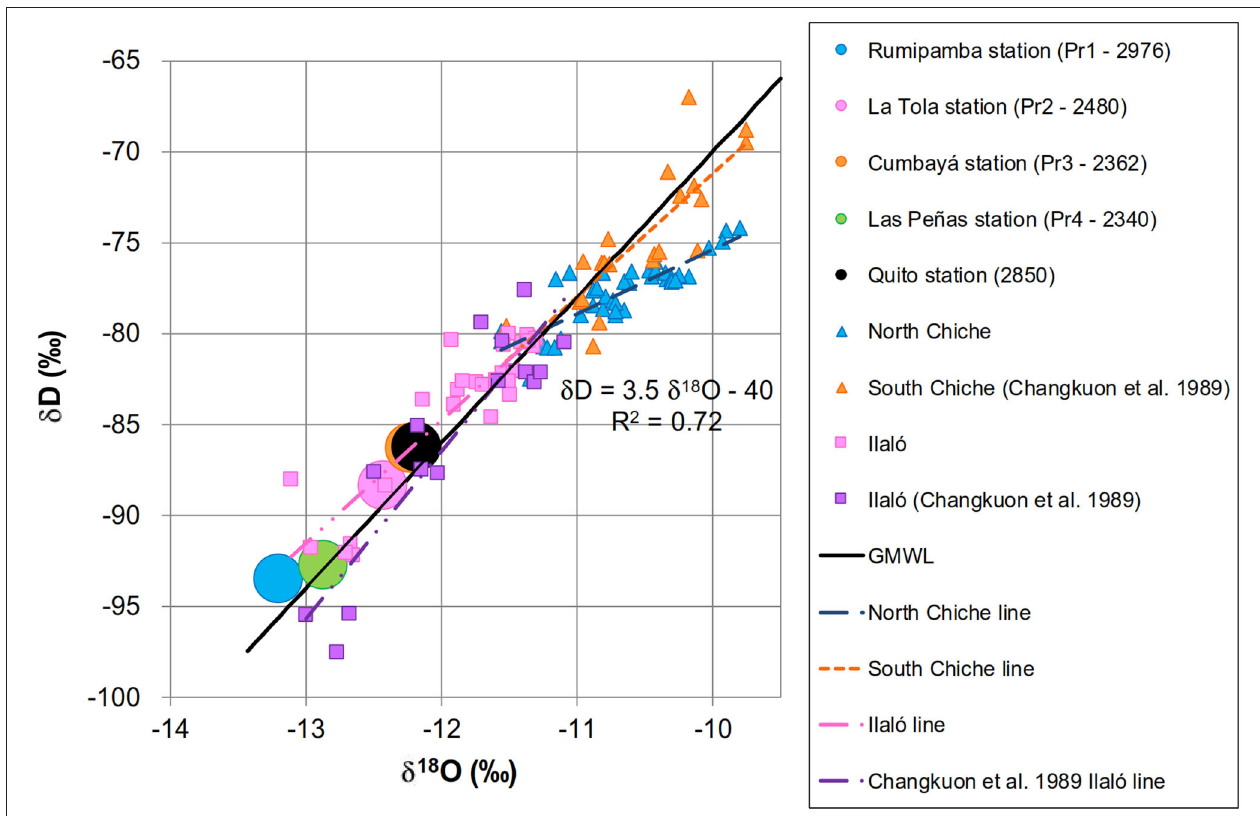
FIGURE 8 | δ D and δ 18 O in rainwater and groundwater. Circles represent weighted mean annual rainfall isotopic composition in the study area. Squares and triangles represent groundwater isotopes from this study and from Changkuon et al. (1989). Global meteoric water line (GMWL) and regression lines for groundwater isotopes from the three aquifers are